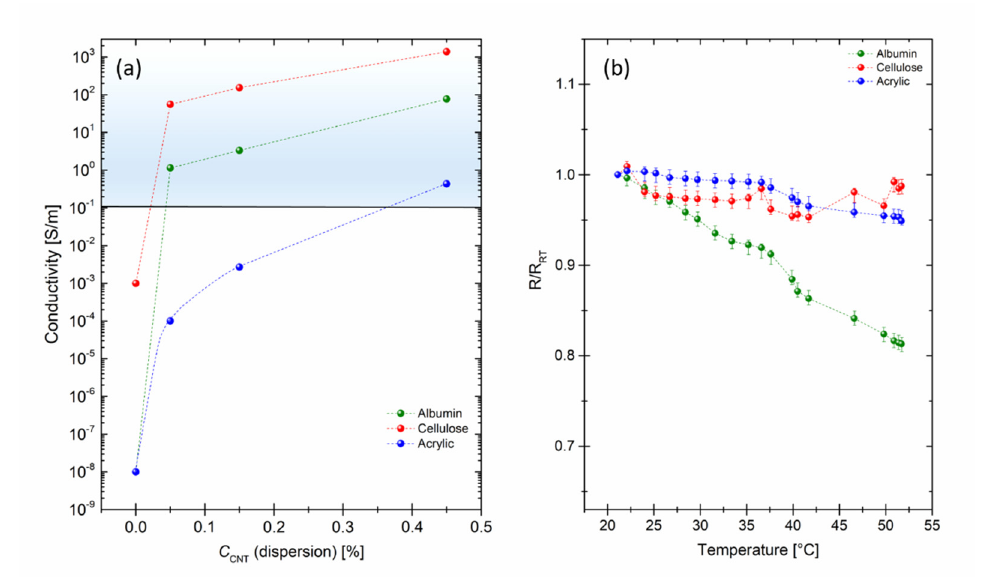
Figure 3. ( a ) Conductivity of albumin (green), cellulose (red) and acrylic polymer (blue)-based composites mixed with 0.05, 0.15 and 0.45 wt.% nanotubes, the blue shaded area indicates the regime of interest for medical and bio applications [3]. ( b ) Normalized resistance (R / R RT ) as a function of temperature for albumin (green), cellulose (red) and acrylic polymer (blue)-based composites mixed with 0.45 wt.% nanotubes. Normalized values are obtained via dividing every measurement value on the first initial value (R RT ).